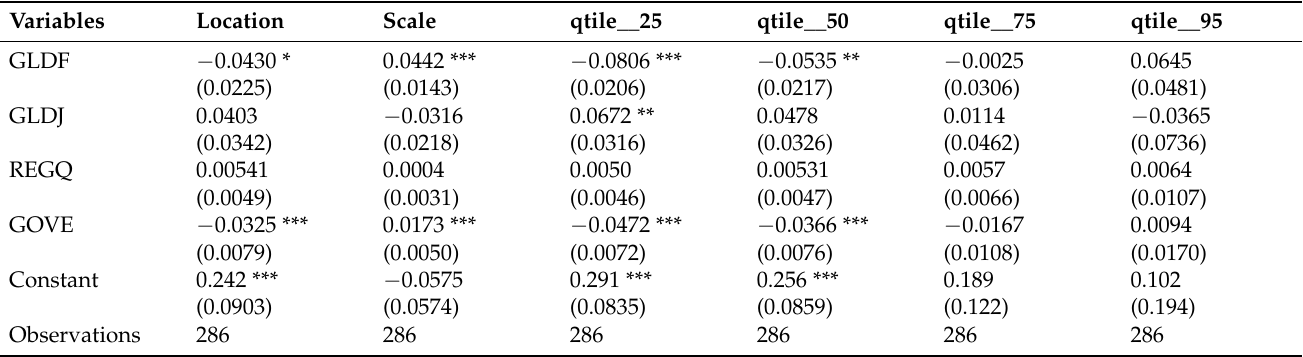
Table 4. Model 2. DV: Income Share of the Top 1% (IN1).